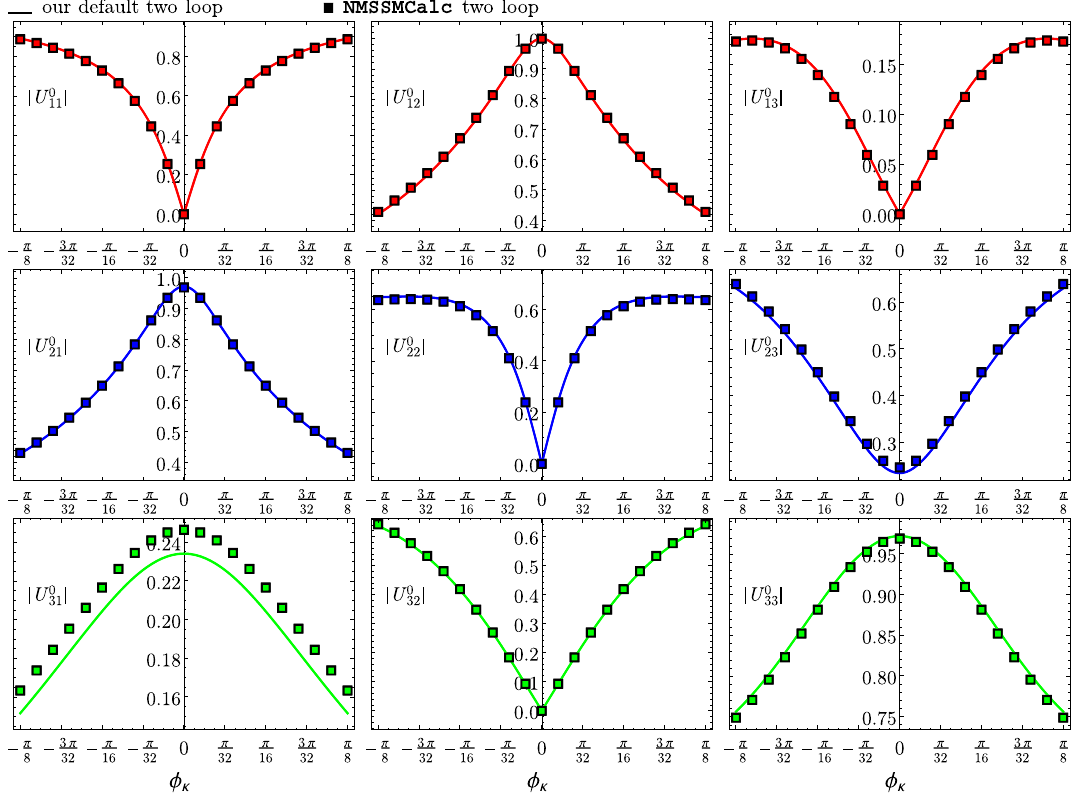
| in our calculation ( full curves ) and in NMSSMCALC ( squares ) for the scenario of Fig. 4 Fig. 6 The matrix elements | U 0 ij